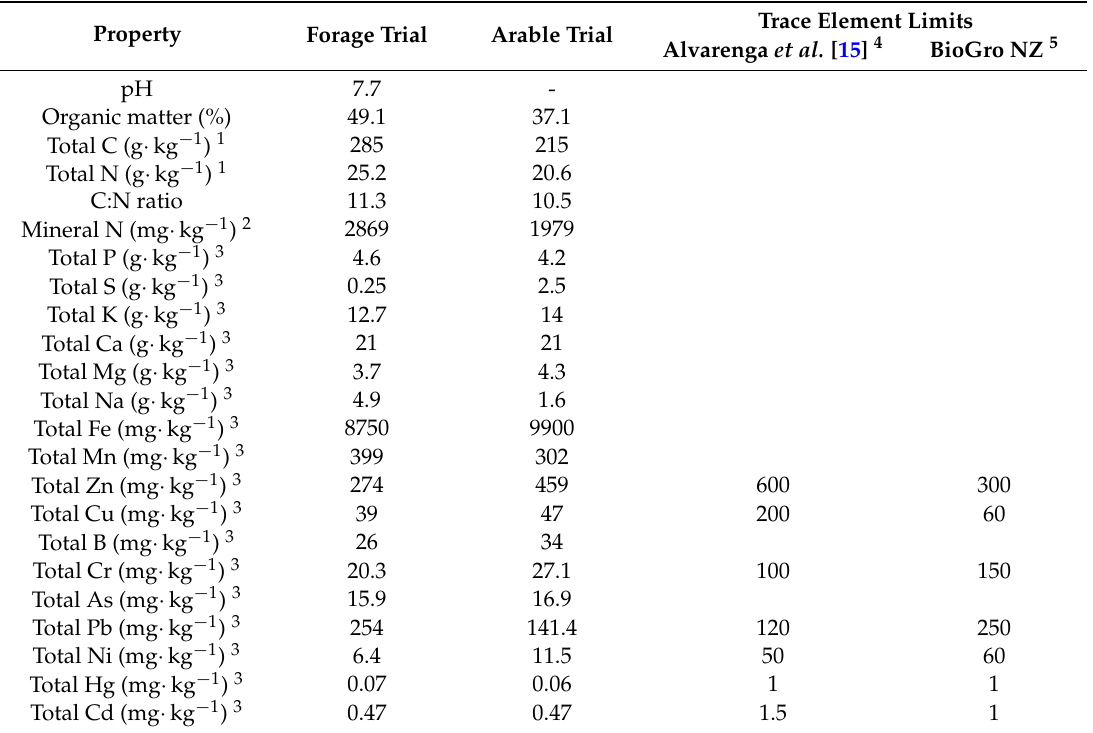
Table 1. Chemical composition of composts used in the Arable and Forage crop trials, values are on a dry weight basis (dry matter contents were 51.2% and 48.9% for the Forage and Arable trials, respectively). Trace Element Limits Property Forage Trial Arable Trial Alvarenga et al. [15] 4 BioGro NZ 5 pH 7.7 - Organic matter (%) 49.1